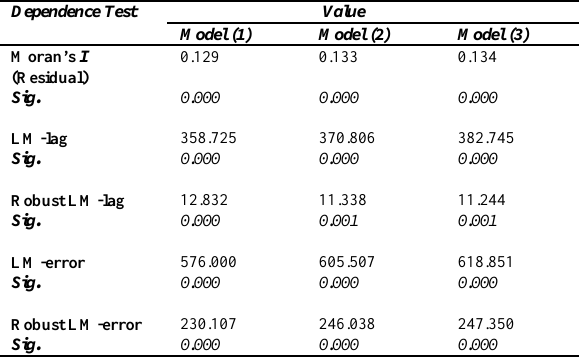
Table 5. Lagrange Multiplier diagnostic tests for SOC- environment relationships. Model (1), (2), and (3) include maximum, mean, and minimum temperature,